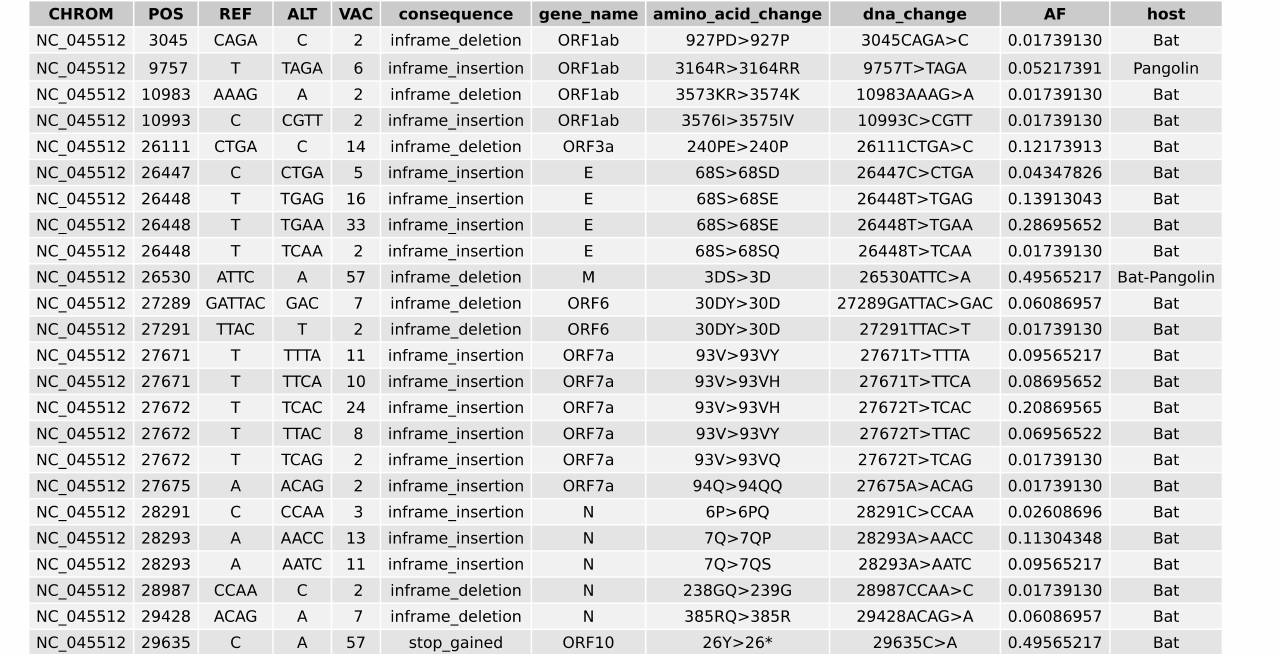
Figure 4. High impact variants identified across bat and pangolin genomes using the variant calling pipeline based on SARS-Cov-2 Ensembl reference genome. The variants with allele frequency > 0.1 and predicted to have HIGH impact